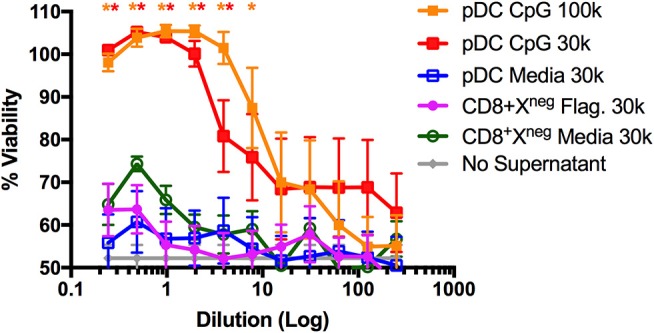
CD8+XCR1neg DCs do not produce Type I IFNs after stimulation with the TLR5 agonist flagellin. DC subsets sorted from the spleens of naïve C57BL/6 mice (Supplementary Figure 1B) were cultured overnight in the presence of TLR agonists Flagellin (Flag.) (100ng/uL), CpG (1 μg/mL) or in media alone at a concentration of 30,000–100,000 DCs/well. After 24 h supernatants were collected, acid treated, serially diluted onto L929 cells and incubated overnight prior to addition of EMCV. After 2 days cells were stained with crystal violet, washed and absorbance was measured at 595 nM. Bioactive IFN production was measured as protection from viral killing compared to no virus control wells. Data are presented as the mean ± SEM of three independent experiments, n = 6. ** represents p < 0.01 and * represent p < 0.05 vs. unstimulated pDC control well. 100 k = 100,000 DC/well, 30 k = 30,000 DC/well.